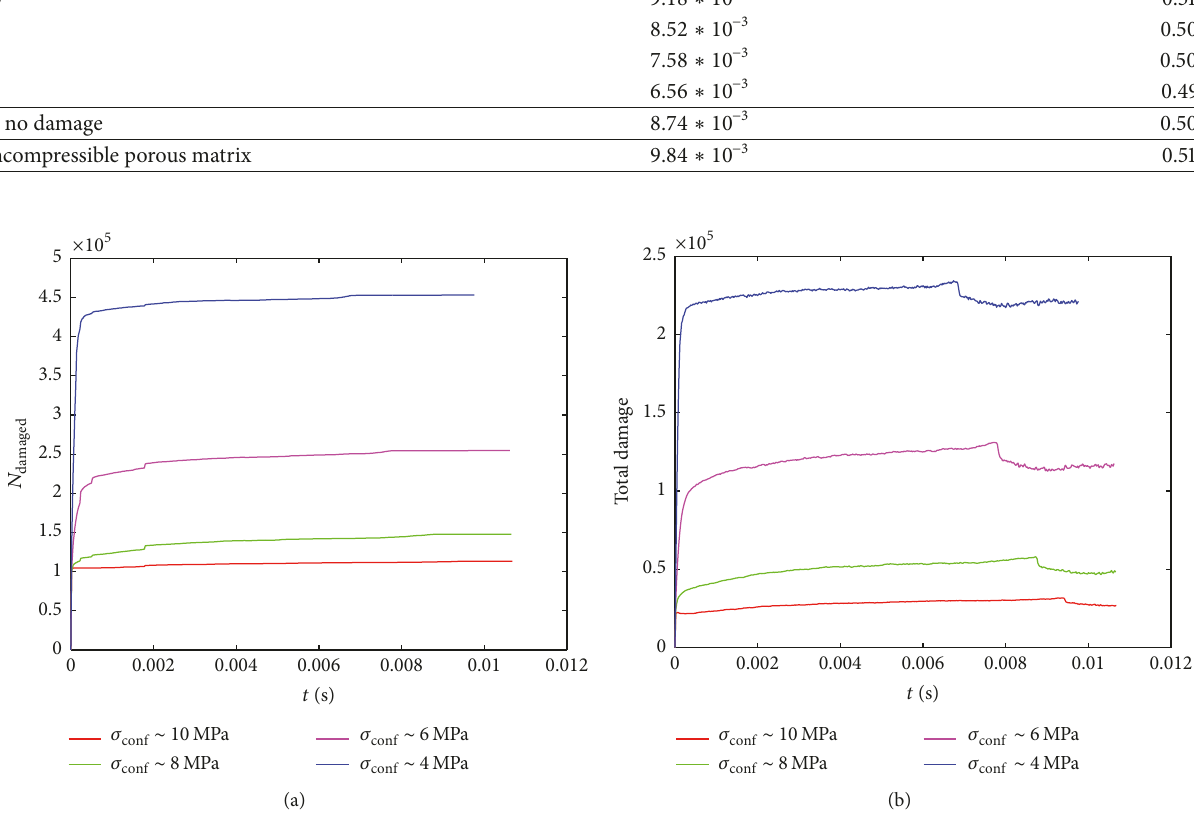
at percolation for various confining stresses. perc